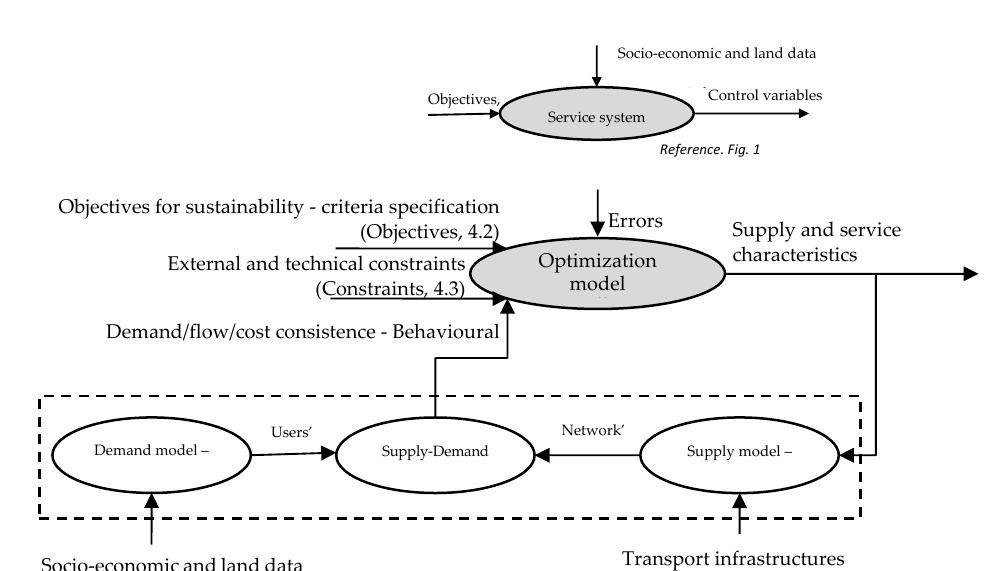
Figure 1. The framework to support S-MaaS policies definition.